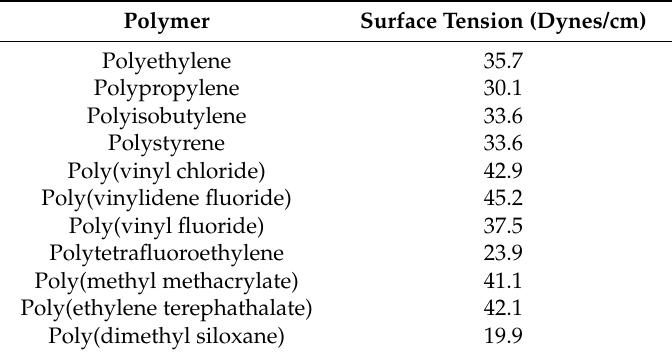
Table 1. Surface tension of selected polymers at 25 ˝ C